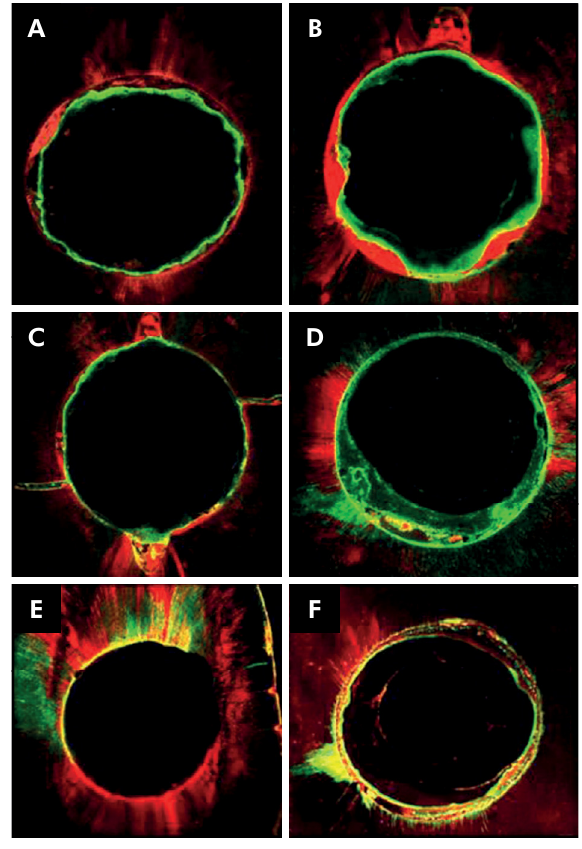
Figure 1. Histotomographic images representing the slices according to each root dentin treatment. A) NaOCl/Panavia F: presence of AH Plus (red) in the dentinal tubules, without evidence of penetration of Panavia F(green); B) NaOCl/RelyX U200: predominance of AH Plus in the dentinal tubules with very few coloured tubules with traces of cementing agent (green); C) NaOCl + EDTA/Panavia F: tubules filled with AH Plus (red) and discreet penetration of Panavia F (green); D) NaOCl + EDTA/RelyX: several tubules filled with root canal sealer (red) and some tubules filled with RelyX U200 cement (green); NaOCl + EDTA + US: several yellow-coloured dentinal tubules resulting from the interaction between the filling material and Panavia F (E) and RelyX U200